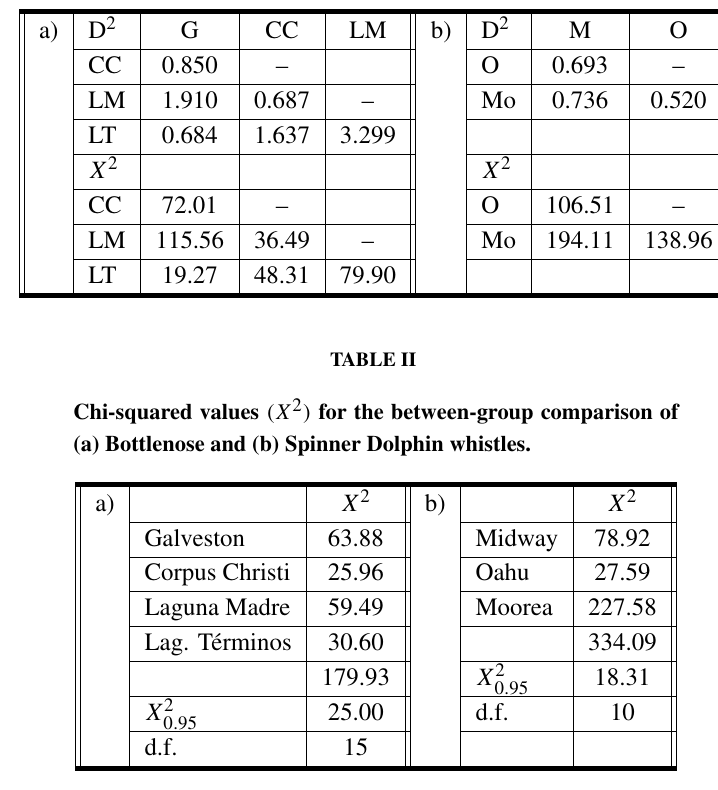
Mahalanobis distances ( D 2 ) and chi-squared values (X 2 ) for the between-group pairwise comparison of (a) Bottlenose and (b) Spinner Dolphin whistles. X 2 16.75 with d.f. = 5. Localities: a) G = Galveston, CC = Corpus Christi, LM = Laguna Madre, LT = Laguna Términos; b) M = Midway, O = Oahu, Mo = Moorea.